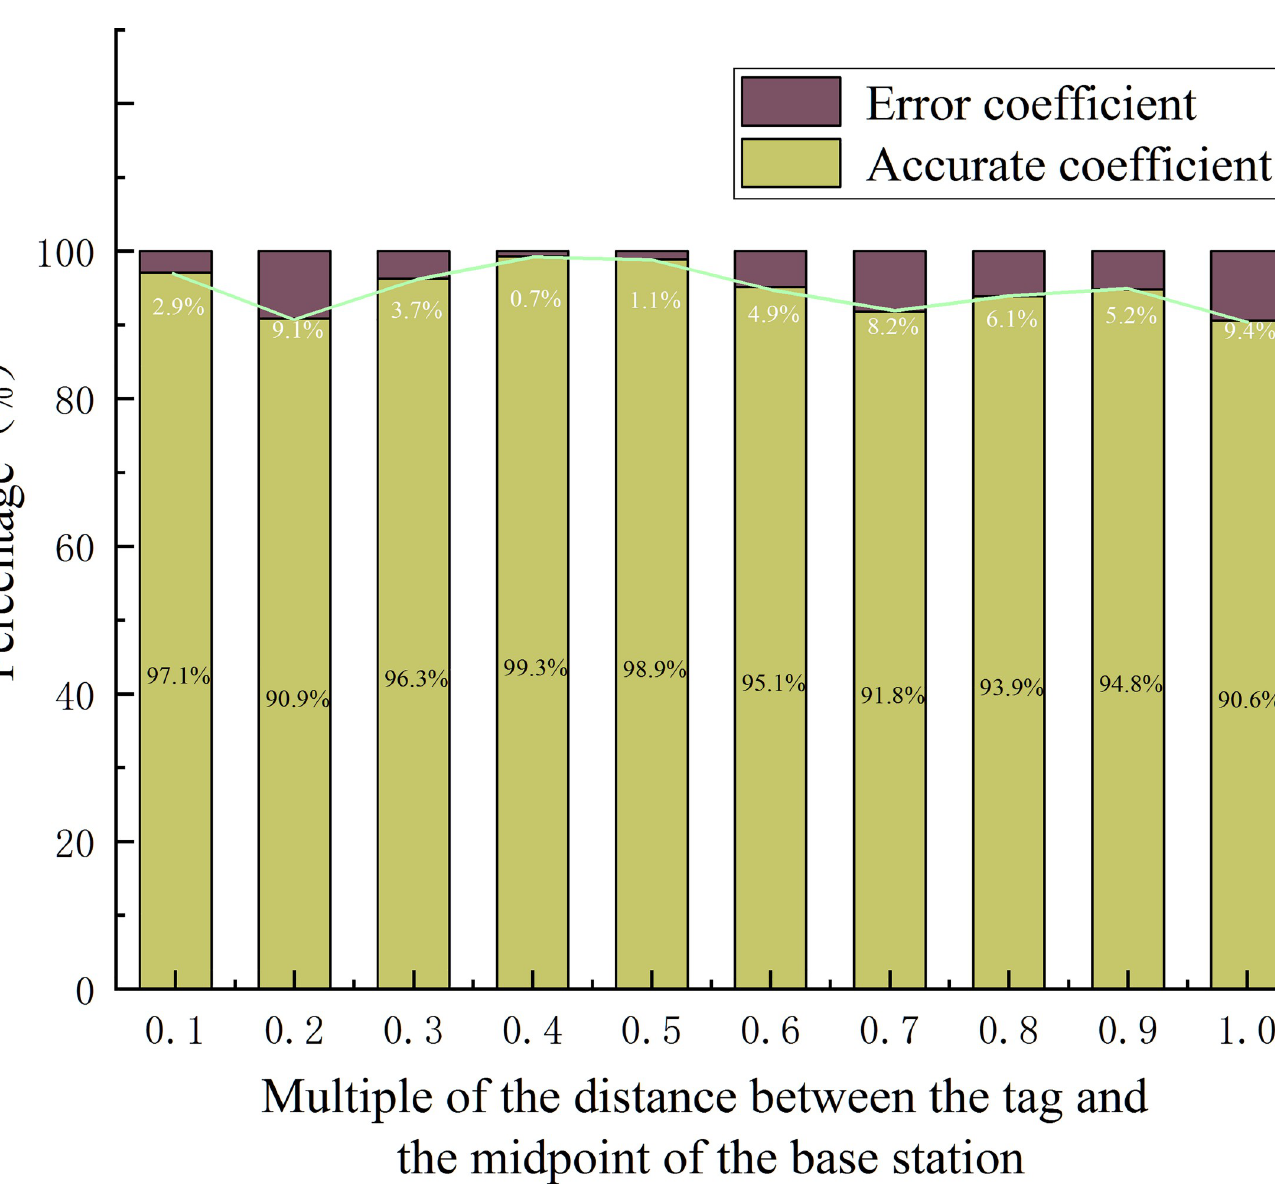
Fig 8. Error in experiment